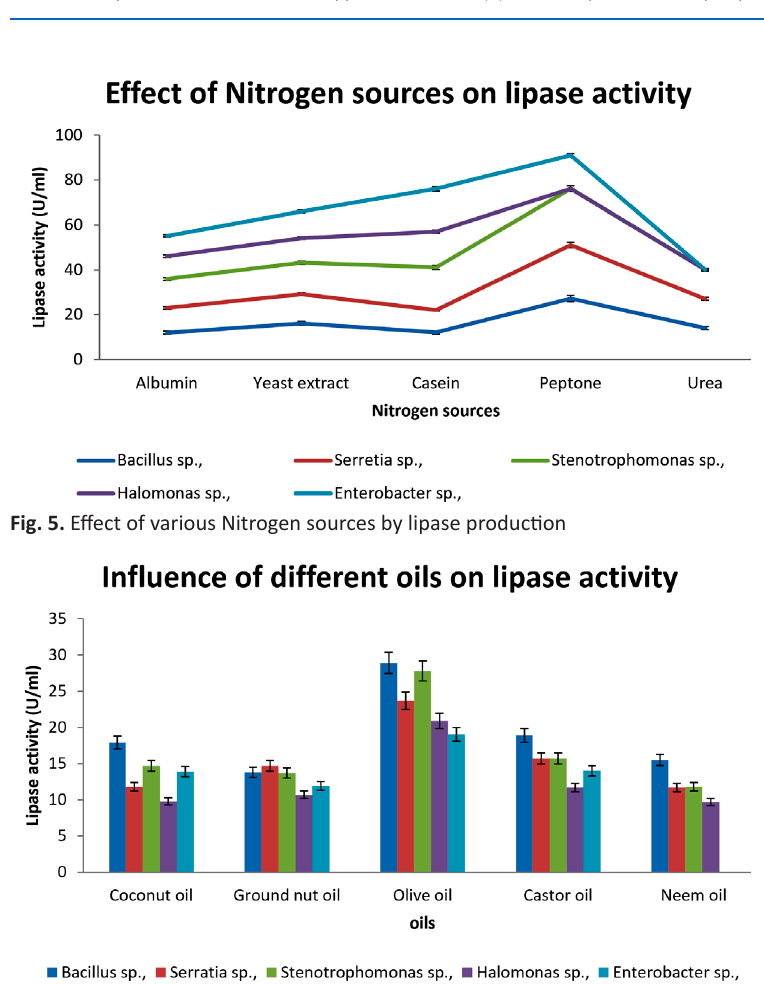
Fig. 6. Influence of different oils on lipase